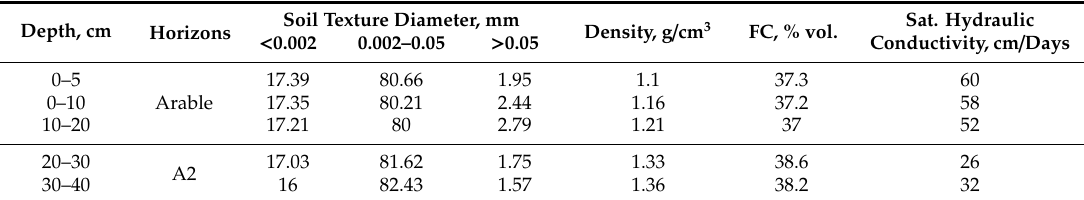
Table A1. Physical and chemical properties of silty loam Phaeozem